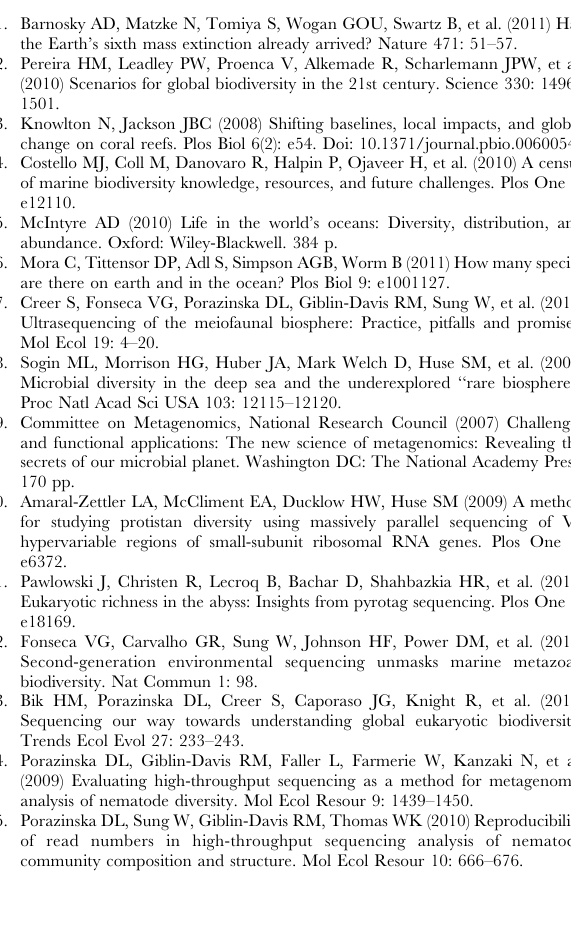
Table S2 Percentages of sequences, which showed mismatches between the previously reported primer [17–19] and target region of the nuclear 28S ribosomal DNA sequences downloaded from the SILVA database. Comparisons were made for each phylum. One and two or more mismatches were estimated independently. The numbers in parentheses indicate the number of sequences that had the mismatches. The hierarchy of the NCBI taxonomy database is followed in this